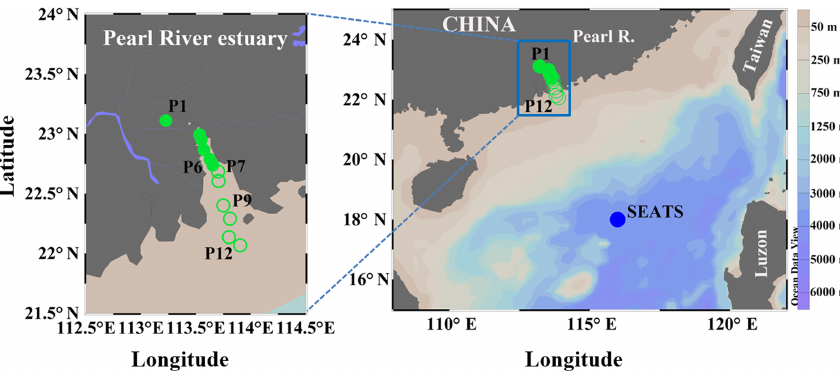
Figure 1. Site locations and bathymetry. The solid green circles indicate hypoxic sites in the PRE, the open green circles indicate (low- )oxygenated sites in the PRE, and the solid blue circle indicates SEATS in the central basin of the SCS. This figure was produced using Ocean Data View v. 4.6.2 (http://odv.awi.de; last access: April 2014). Isobaths are regarded as the background, and the color bar indicates